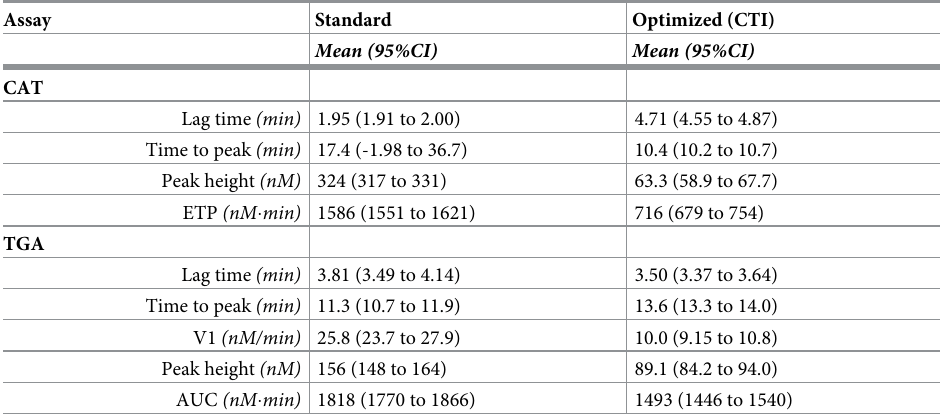
Table 2. Mean results with 95%CI in subjects for both Calibrated Automated Thrombogram (CAT) and Techno- clone Thrombin Generation Assay (TGA).